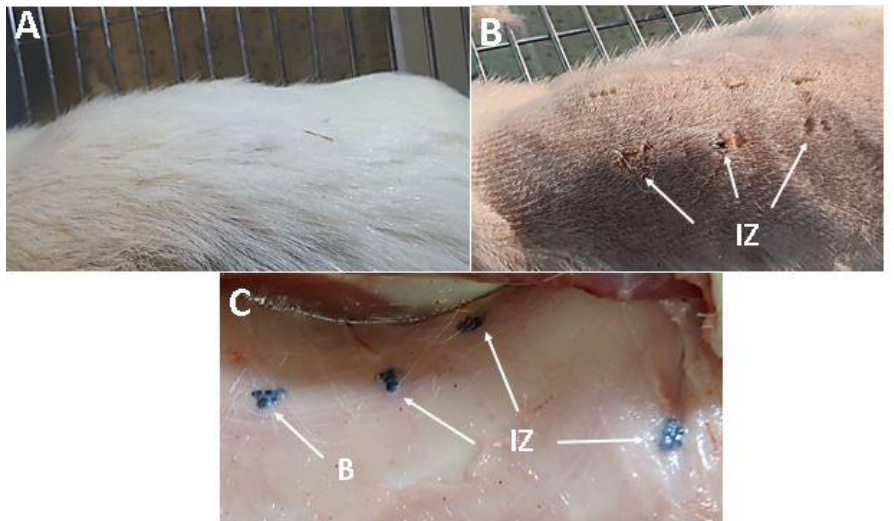
Figure 8. Zone of subdermal implantation in Wistar rats after 30, 60, and 90 days ( A ) Hair recovery, ( B ) Absence of immune responses, ( C ) Subdermal implantation zones with samples encapsulated by scar tissue. B: Beads. IZ: Implantation zone. Molecules 2020 , 25 , x FOR PEER REVIEW